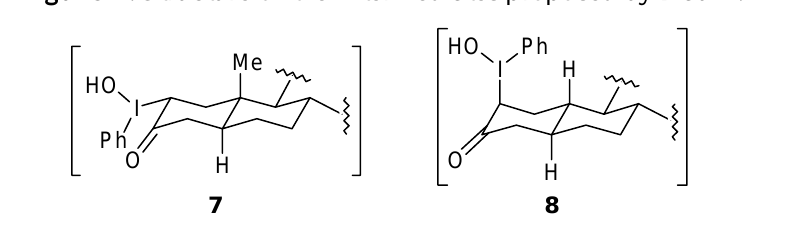
Figure 1 . Structure of the Intermediates proposed by